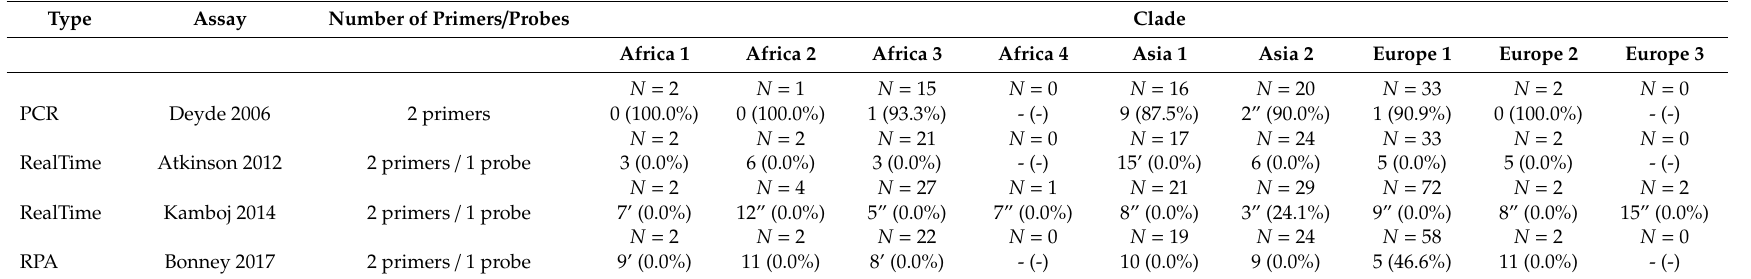
Table 3. Scoring summary of the molecular assays with an annealing site lying in the extreme 5’ or 3’ non-coding